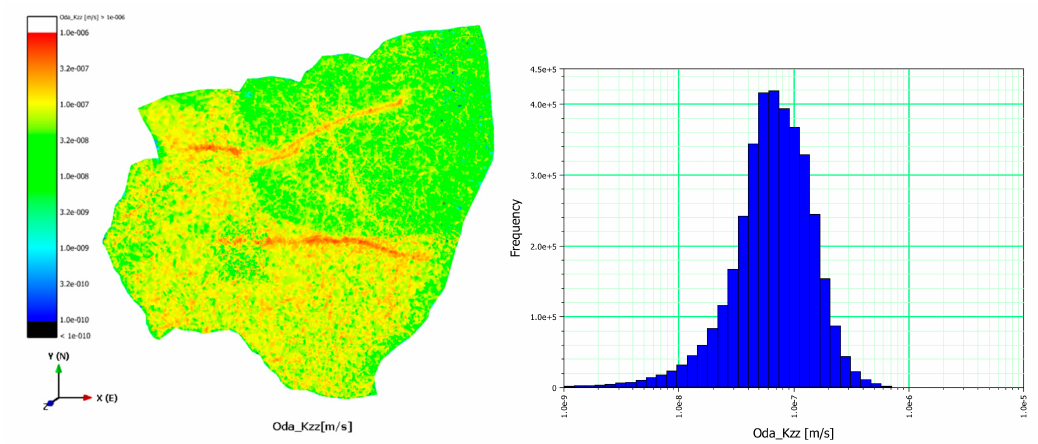
Figure 13. Upscaled hydraulic conductivity tensor in z-direction, K zz [m/s].